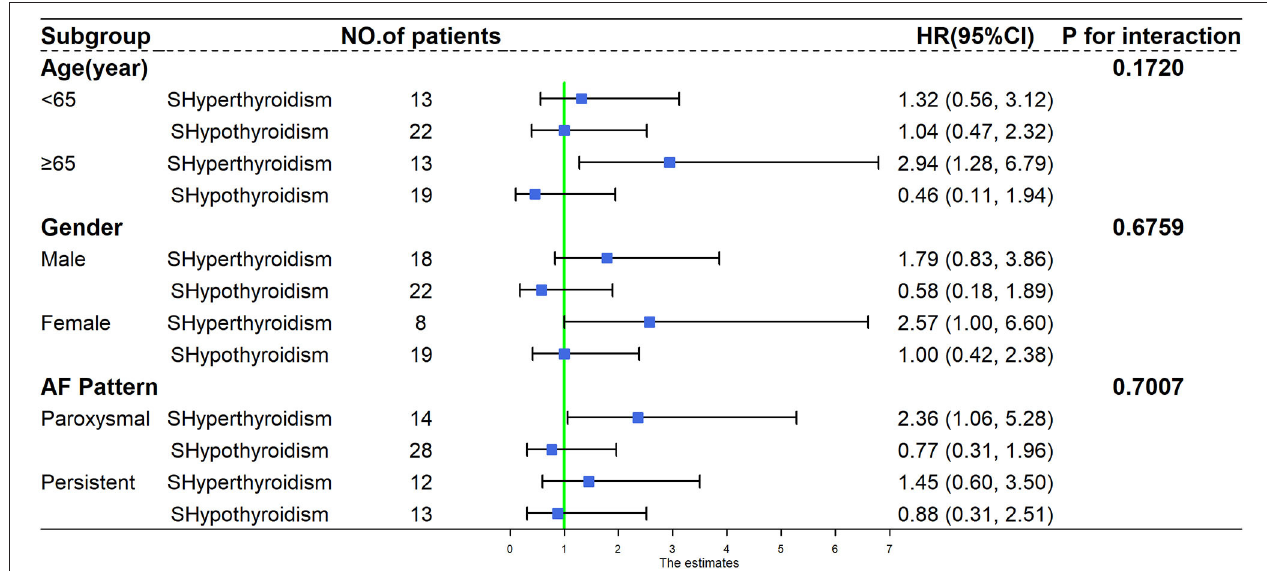
FIGURE 4 | Subgroup analysis of recurrence of atrial fibrillation according to different age, gender, and atrial fibrillation pattern. HR, hazard ratio; CI, confidence interval; AF, atrial fibrillation; SHyperthyroidism, subclinical hyperthyroidism; SHypothyroidism, subclinical hypothyroidism.